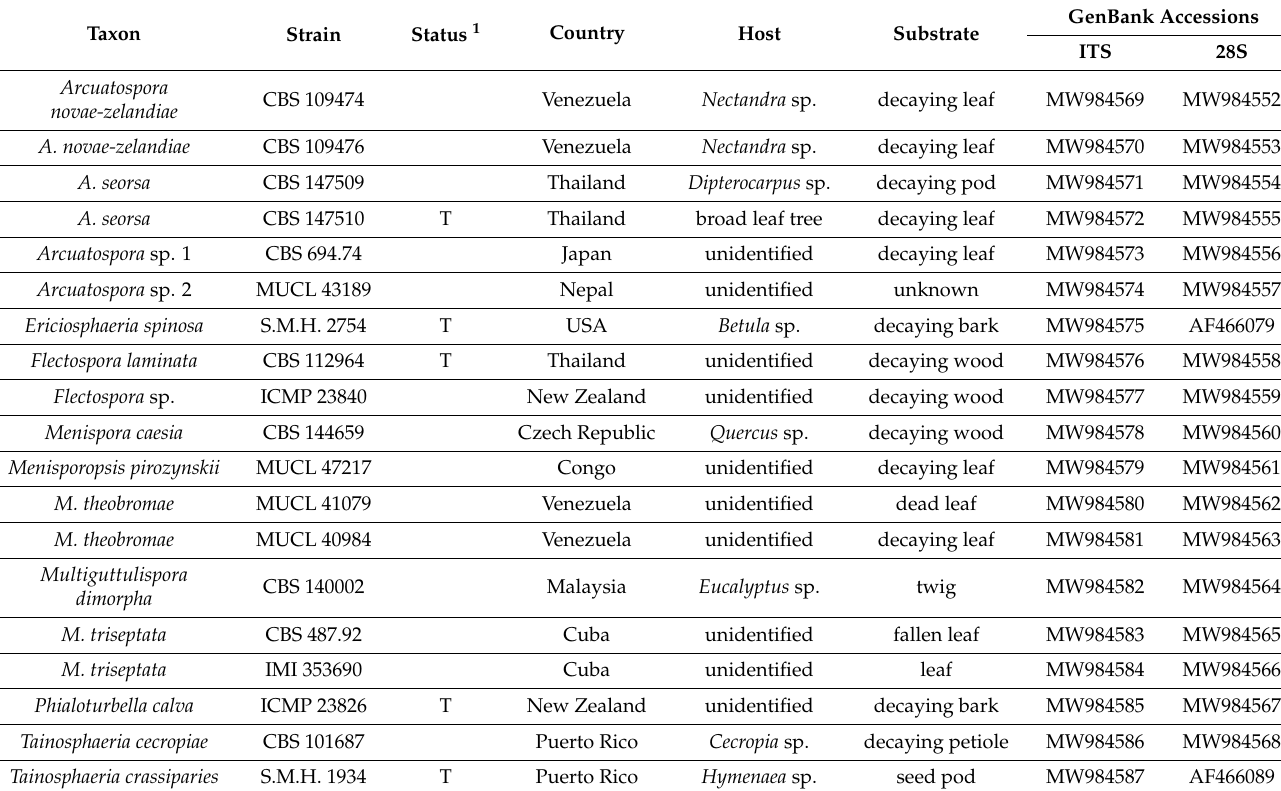
Table 1. Taxa, isolate information and GenBank accession numbers for sequences. New sequences determined for this study and taxonomic novelties are given in